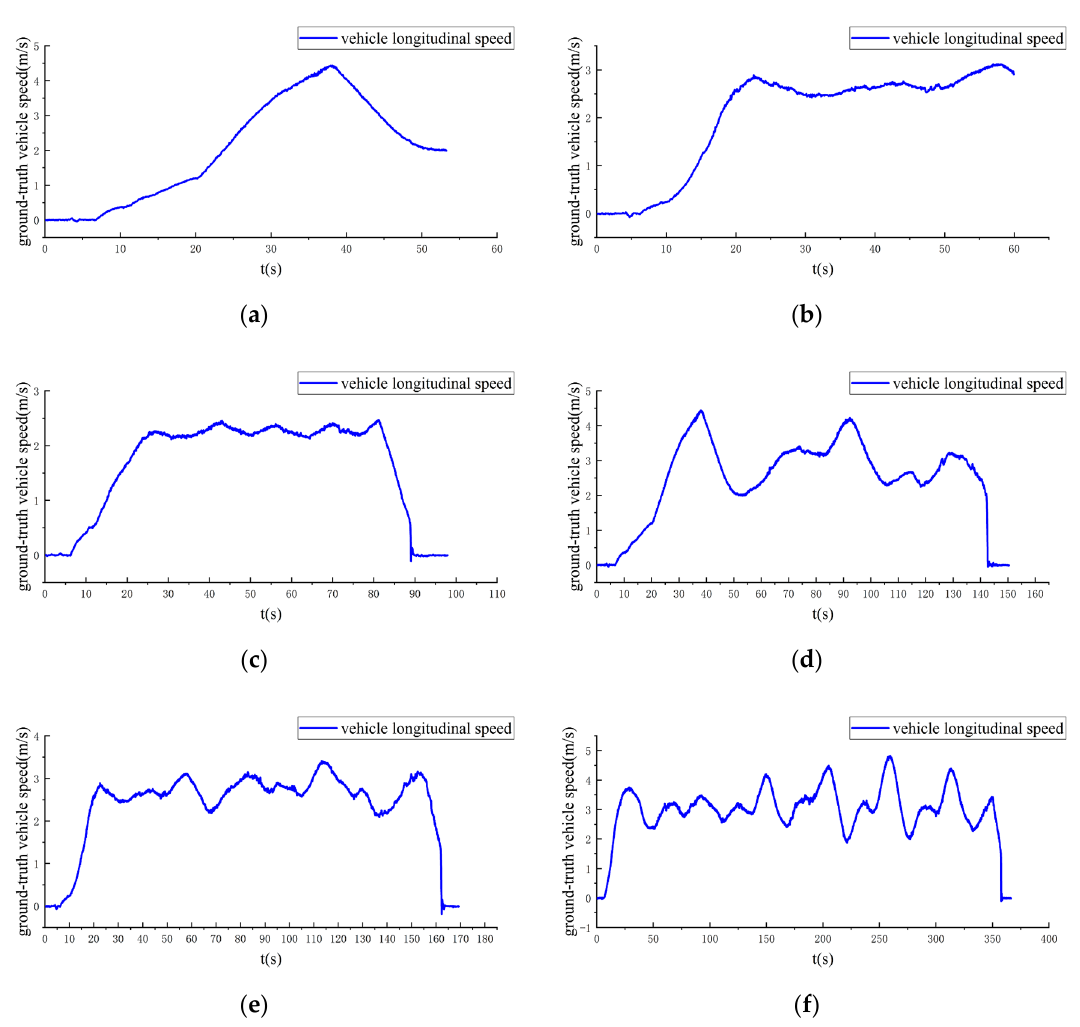
Figure 3. The ground-truth vehicle longitudinal speeds for the datasets: ( a ) VD01; ( b ) VD02; ( c ) VD03;